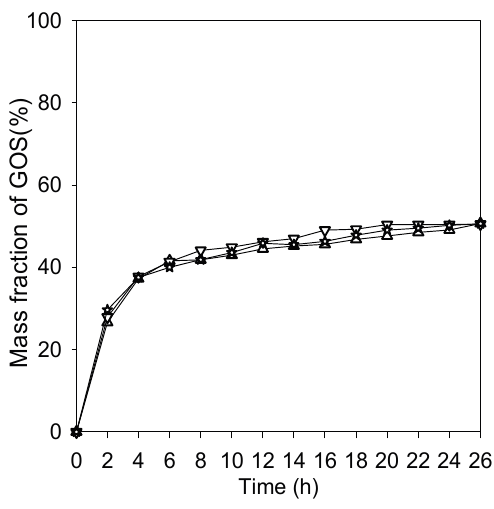
Figure 8. Total GOS production for the three enzyme systems. ( Δ ) total GOS of free enzyme; ( ▽ ) total GOS of Fe 3 O 4 -CS-immobilized enzyme; ( ☆ ) total GOS of Fe 3 O 4 -CS-THP-immobilized enzyme.